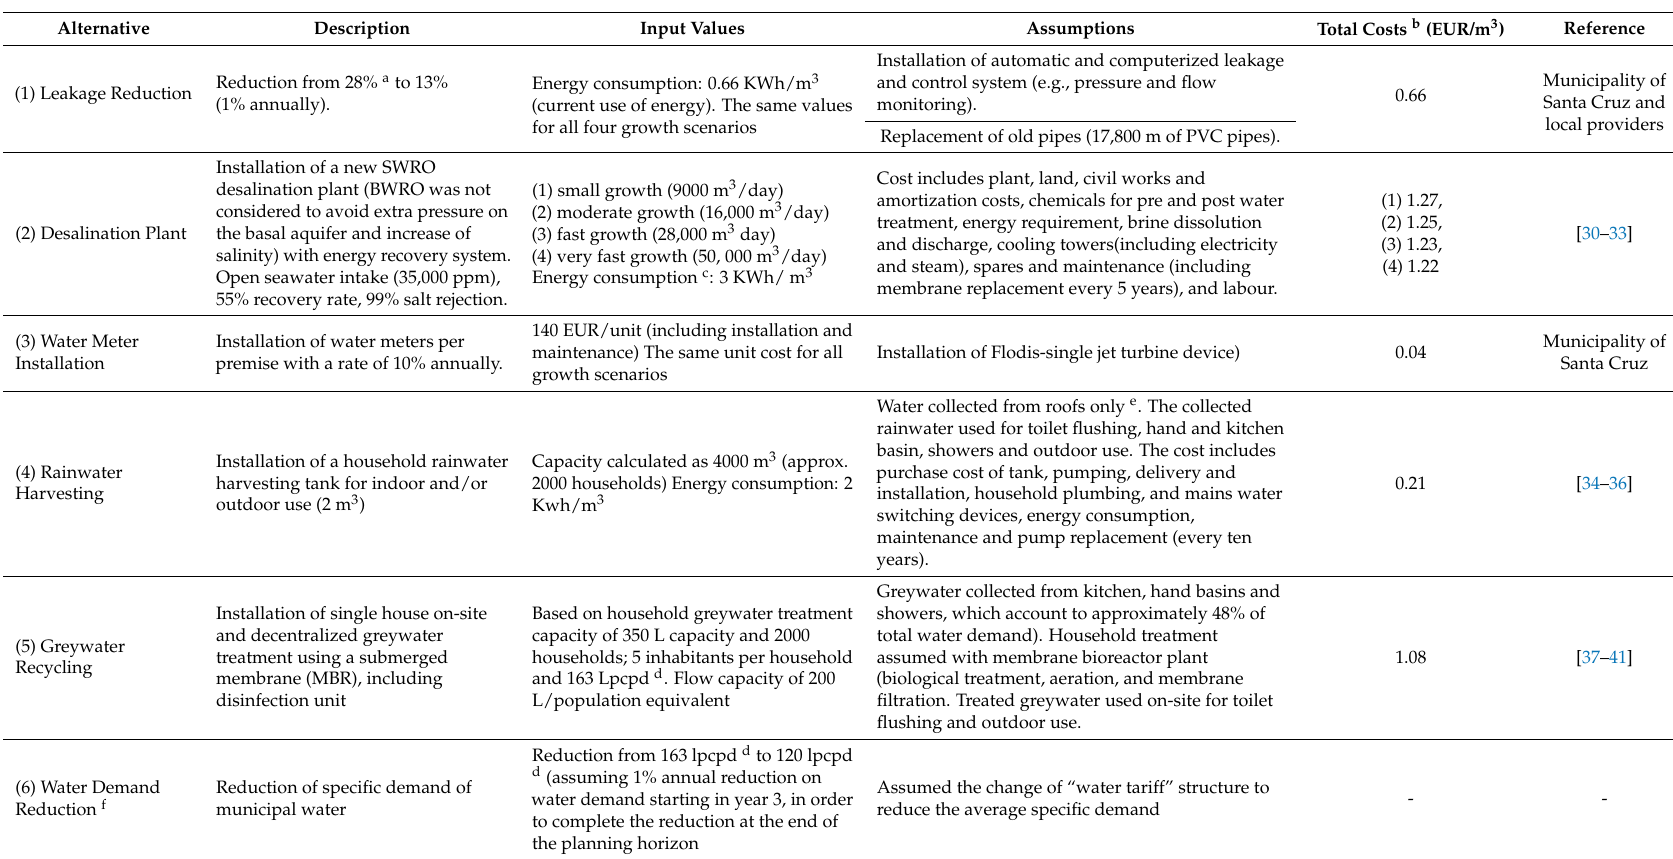
Table 6. Suggested alternatives for improvement of the